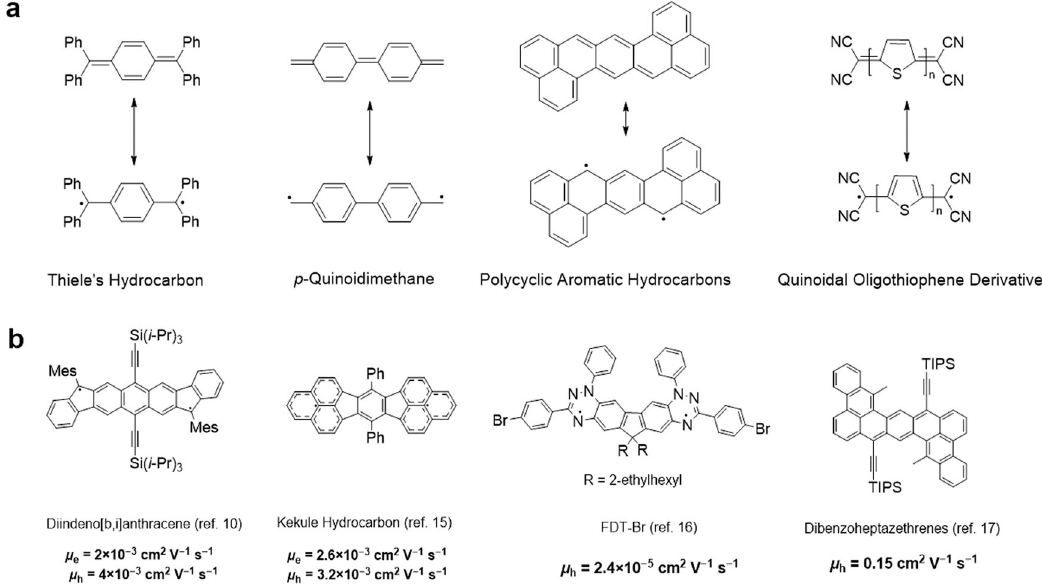
Fig. 1 Previous works on the design and synthesis of open-shell or high-spin π -conjugated organic molecules. a Resonance structures of several open- shell π -conjugated organic molecules. b Some representative open-shell or high-spin organic semiconductors and their charge carrier